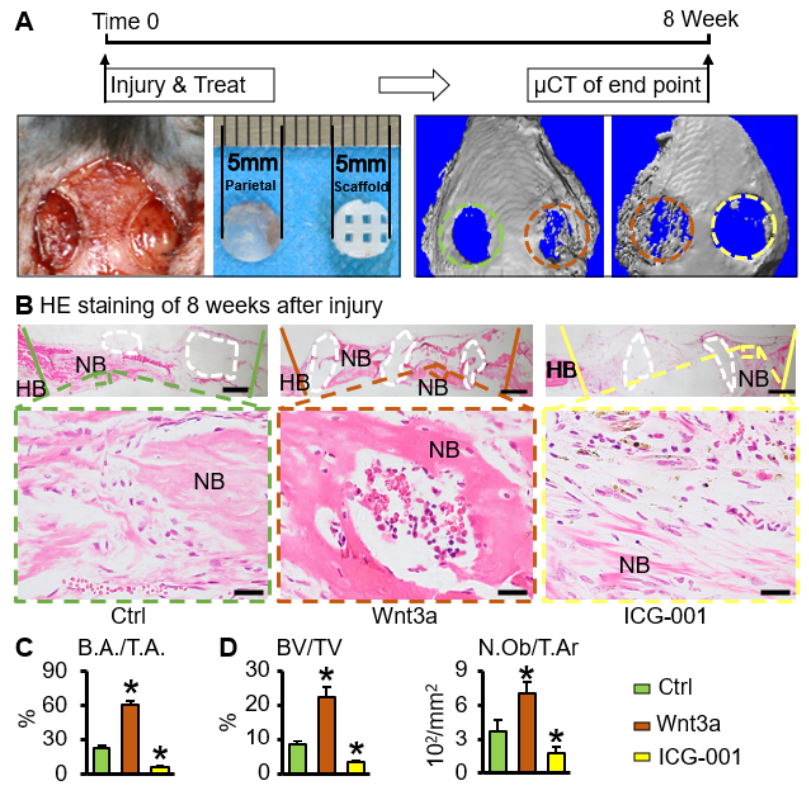
Figure 6. Wnt3a pretreated ST2/GelMA/PCL scaffold accelerates bone regeneration in mice critical- size bone defects. ( A ) Animal experiment. Critical-size bone defect (5 mm in diameter) was estab- lished in the parietal of the 6-week- old male mice, and then the scaffolds were implanted. μCT im- age of bone defect at 8 weeks after surgery (green circle is the ctrl group, the brown circle is the Wnt3a group, the yellow circle is the ICG-001 group) and ( C ) quantitative analysis of the bone area per the tissue area (B.A./T.A.). ( B ) HE staining of the tissue section at the bone defect; the white dotted area is polycaprolactone. HB, host bone. NB, New bone. ( D ) Static histomorphometric anal- ysis, bone volume per tissue volume (BV/TV), osteoblast number per tissue area (N.Ob/T.Ar). Small figure, scale bar: 400 µm. Magnification image, scale bar: 20 µm. Compared with ctrl group, * p < 0.05 by one-way ANOVA, n = 5. 2.6. Wnt3a Pretreated Bone Repair Scaffolds Promote Vascularization Eight weeks after surgery, there was a large amount of neovascularization in the Wnt3a group compared with the control group in bone tissue sections (Figure 7A). Quan- titative analysis of blood vessels showed that the Wnt3a group was 2.39 times ( p < 0.05) higher than that of the control group and 4.78 times higher than that of the ICG-001 group ( p < 0.05) (Figure 7B). Furthermore, Wnt3a increased the amount of VEGF-A in cells (Fig- ure 7E) and conditioned medium (Figure 7F) of the ST2/GelMA/PCL scaffolds, which pro- moted tubule formation of HUVEC cells in vitro (Figure 7C,D). It is shown that the func- tionalized ST2/GelMA/PCL bone repair scaffold promotes vascularized functional bone formation.